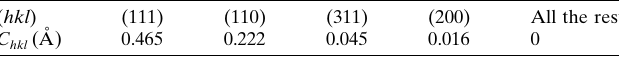
Table 10 Magnitudes of C hkl in diamond/C (space group type Fm (cid:4) 33 m ).